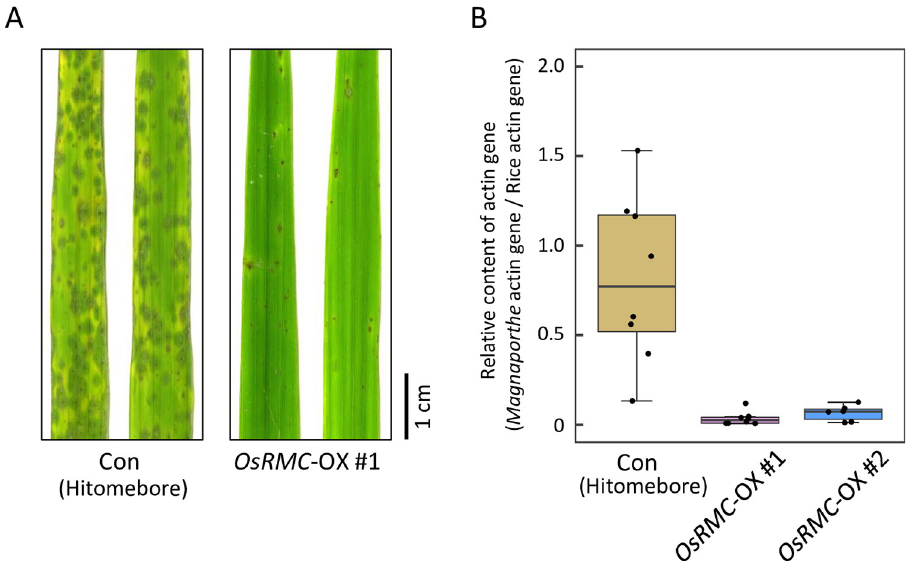
Fig 5. OsRMC -overexpressing rice plants show enhanced resistance against M . oryzae . (A) Rice leaves of wild-type (Hitomebore) control (Con) and OsRMC -overexpressing ( OsRMC- OX) lines 4 days after inoculation of M . oryzae (Ken53-33, 1.5 X 10 6 conidia) inoculation. The M . oryzae infection test was conducted using wild-type control ( n = 10) and OsRMC -OX (#1 [n = 6] and #2 [n = 6]) lines. (B) M . oryzae infection is suppressed in OsRMC- OX lines. The amount of M . oryzae fungal mass in rice leaf was monitored by quantifying the ratio of M . oryzae genomic DNA to rice genomic DNA, determined by qPCR of the respective actin genes. The average ΔΔ Ct value in wild-type control lines was defined as the unit for the ratio. Data are means ± SD of independent determinations. Double asterisks indicate a significant difference at P < 0.01, respectively, according to Student’s t -test.